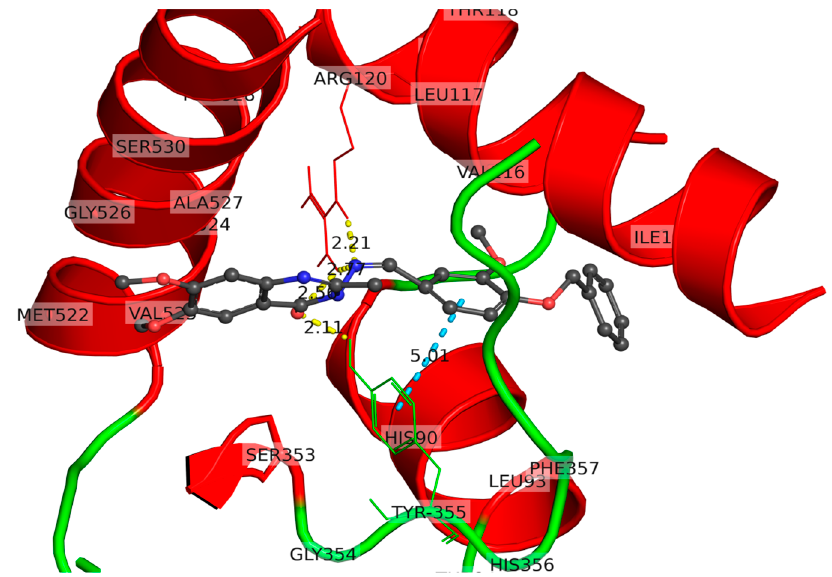
Figure 8. Three-dimensional docking pose of molecule ( 6d ) in the active site of COX-2.